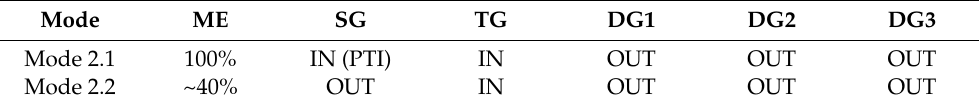
Table 2. RT-Flex 82C L11 3 engine room and modes of operation.